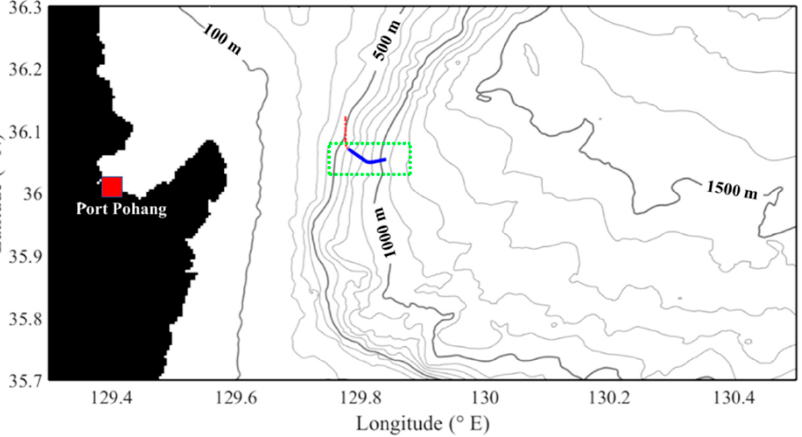
Figure 1. Bathymetry of the southwestern continental margin of Ulleung Basin, East Sea. The red dashed line is the trajectory of R/V Cheonghae before the 3 kHz CW measurements. As R/V Cheonghae moved east along the solid blue track, the 3 kHz CW experiment was conducted. The green dotted box surrounds the experimental site.